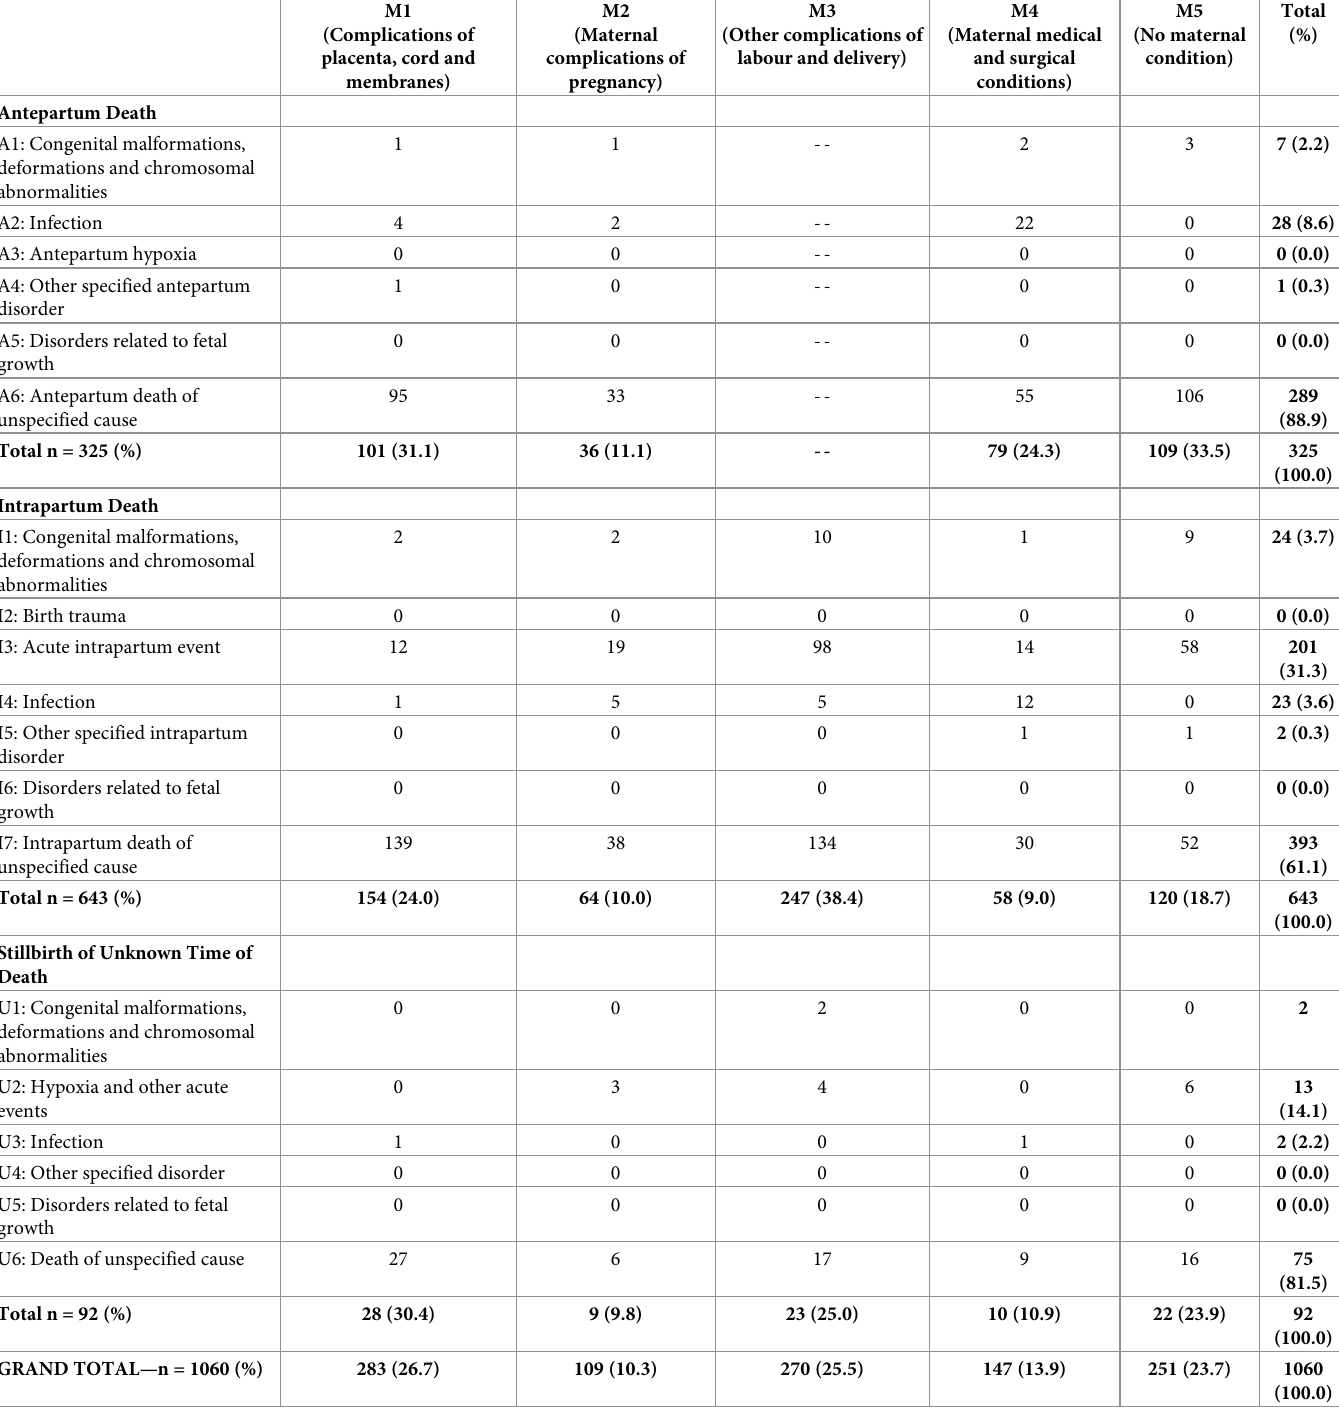
Table 4. Application of ICD-PM to cause of